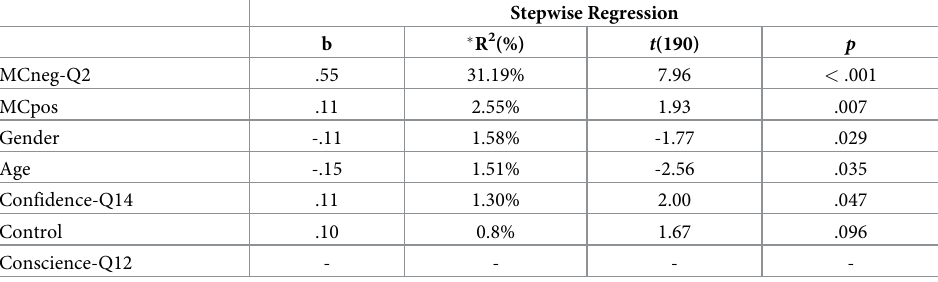
Table 6. Stepwise linear regression of the 5 factors of the MCQ-Af27 plus age and gender on total anxiety scores, N =